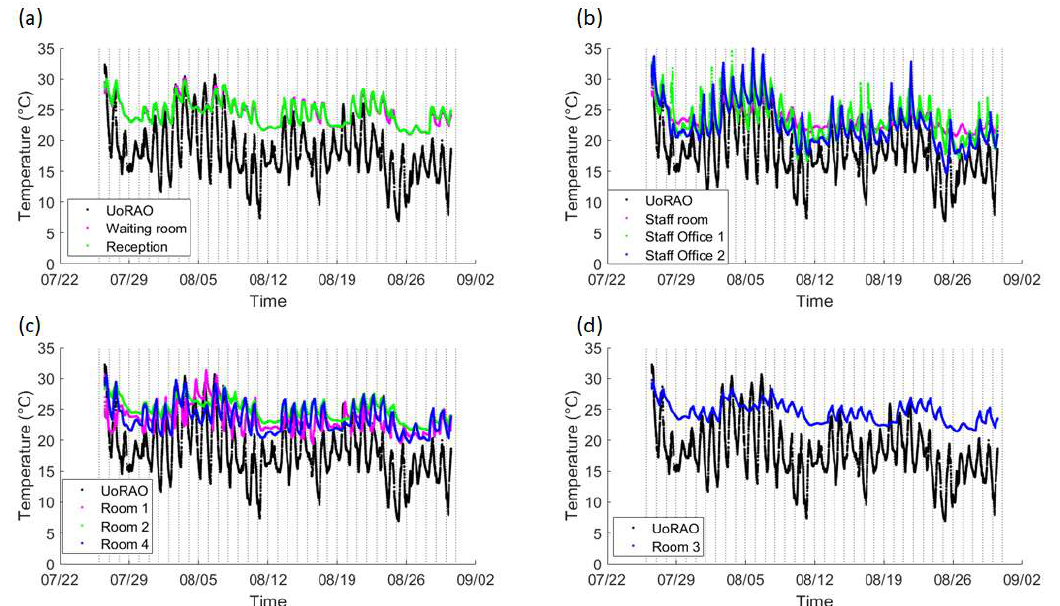
Figure 6. Overview of the temperatures recorded for the entire study period. Vertical lines denote midnight of each day. For clarity, similar rooms are plotted on one subplot, (a) Observatory (UoRAO), waiting room and reception, (b) UoRAO and Staff room and offices, (c) UoRAO and the naturally ventilated scanning rooms (Room 1,2,4) and (d) UoRAO and room 3, the air-conditioned room. All plots have the same axis.